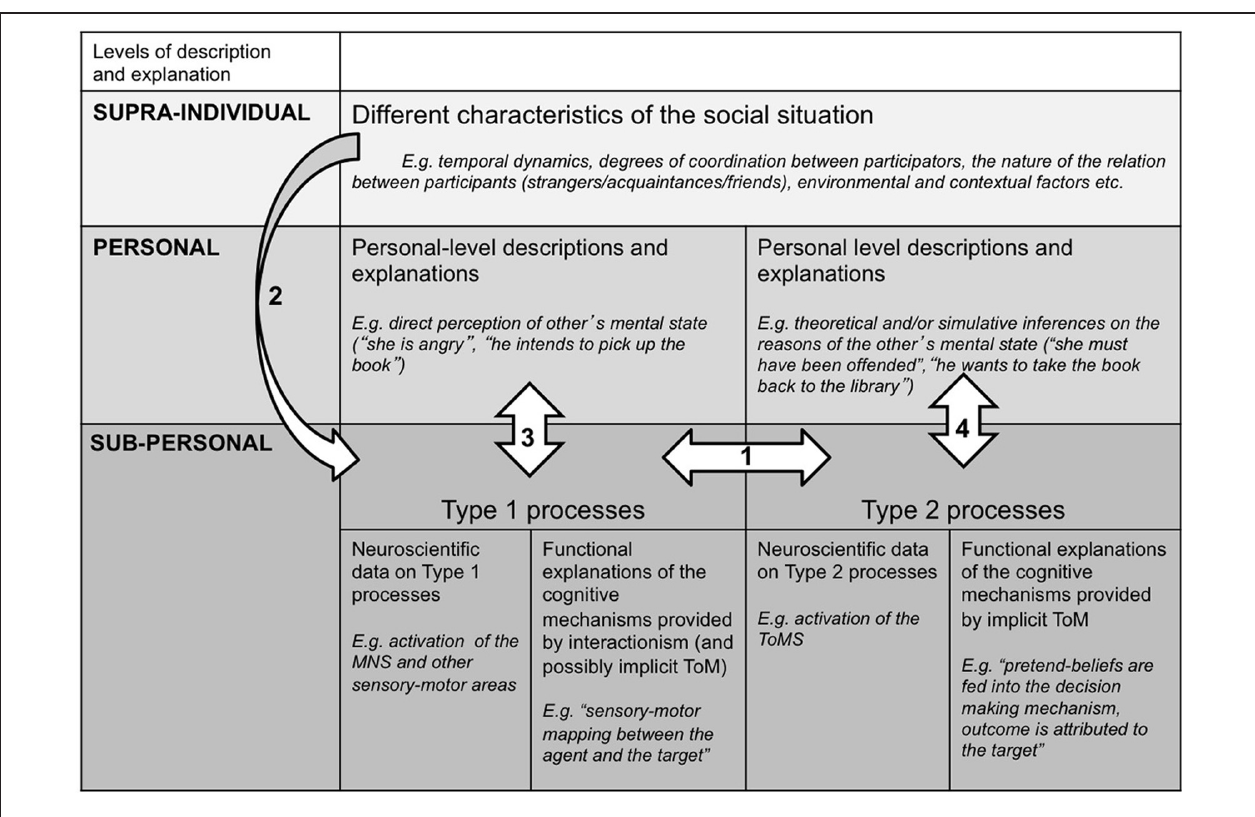
FIGURE 1 | An integrative account of social